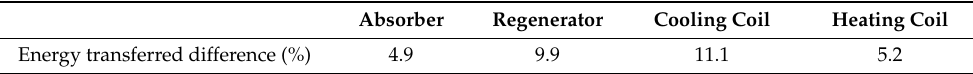
Table 6. Annual difference between the measured and calculated energy